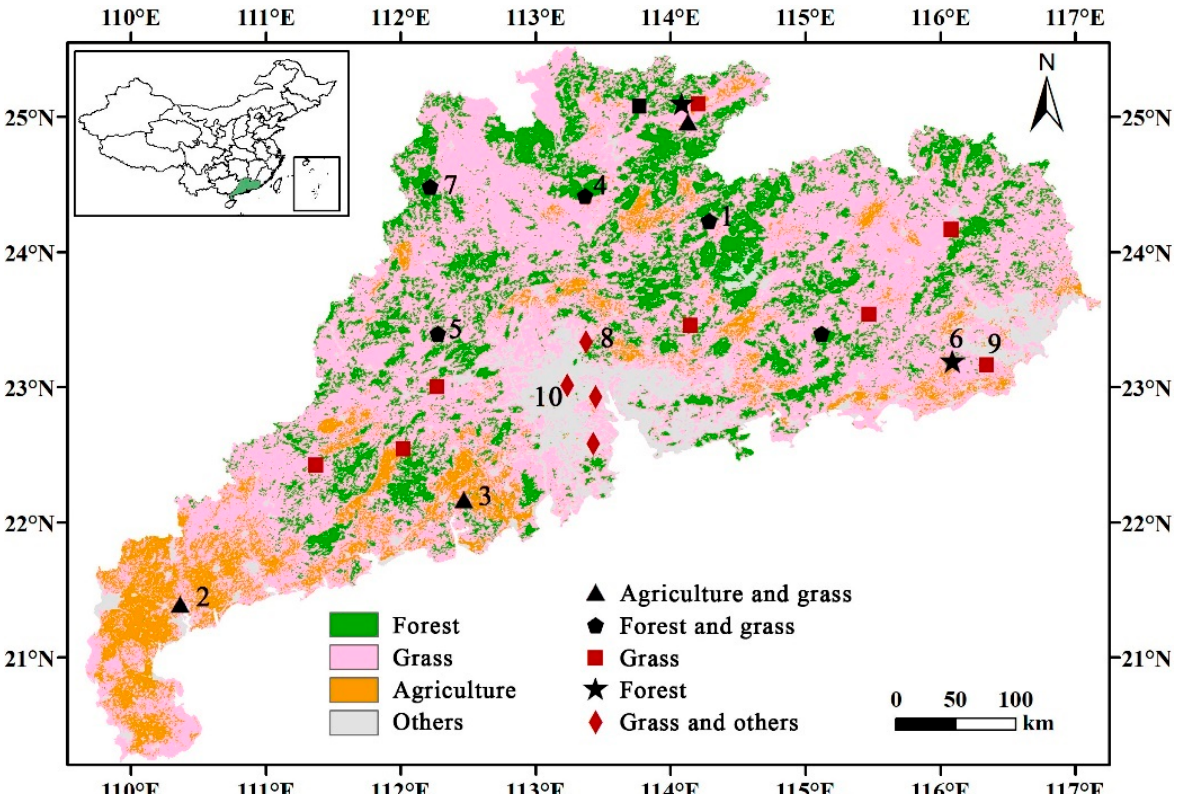
Figure 1. Land use/land cover of the study area and the location of VSWC stations. Only the stations that have extracted the time series curve are numbered. Different colors represent different land use/land cover types. Different styles of points represent main land use/land cover types within 5 × 5 pixels of the stations.